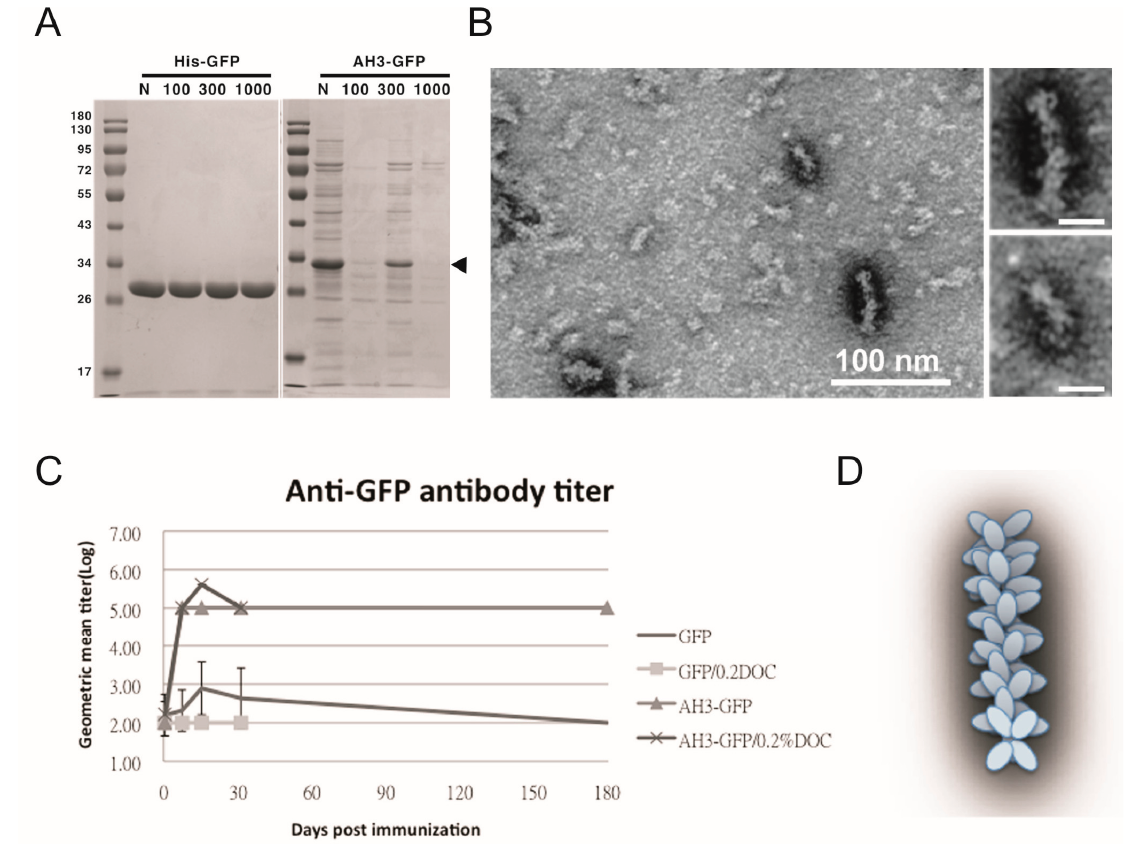
Figure 1. Characterization of GFP fusion protein oligomerization. ( A ) GFP and AH3–GFP fusion proteins purified and reconstituted in PBS were centrifuged through a size-exclusion membrane with a different molecular weight cut off (MWCO). The filtrate was then analyzed by 12% SDS-PAGE and coomassie blue staining. The position of AH3–GFP is marked by an arrow head. ( B ) The oligomerization of AH3–GFP protein was analyzed by negative staining using a transmissive electronic microscope (TEM). Scale bar represents 100 nm. Two of the representative particles are enlarged and shown in the right panels. (Scale bar = 20 nm) Images have been processed by Gaussian Blur filter using Photoshop. ( C ) The antigenicity of GFP and AH3–GFP fusion protein was evaluated by immunizing mice by single muscular immunization. The anti-GFP IgG titers were followed for 6 months by ELISA. (N = 5). Two samples (GFP/0.2% DOC and AH3–GFP/0.2% DOC) also included 0.2% deoxycholate when immunizing mice. ( D ) AH3–GFP protein nanoparticle model predicted from TEM images.